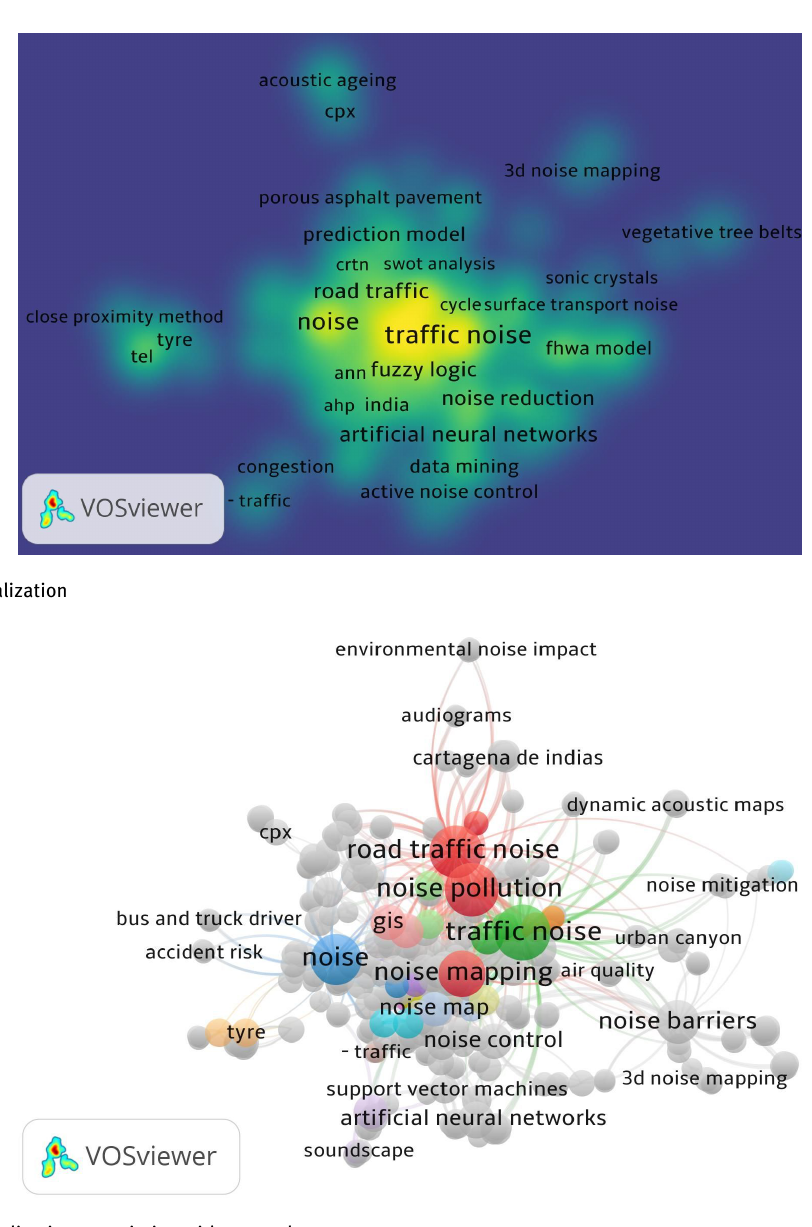
tering maps examining the network of co-citation, or of co-occurrence of the terms in various